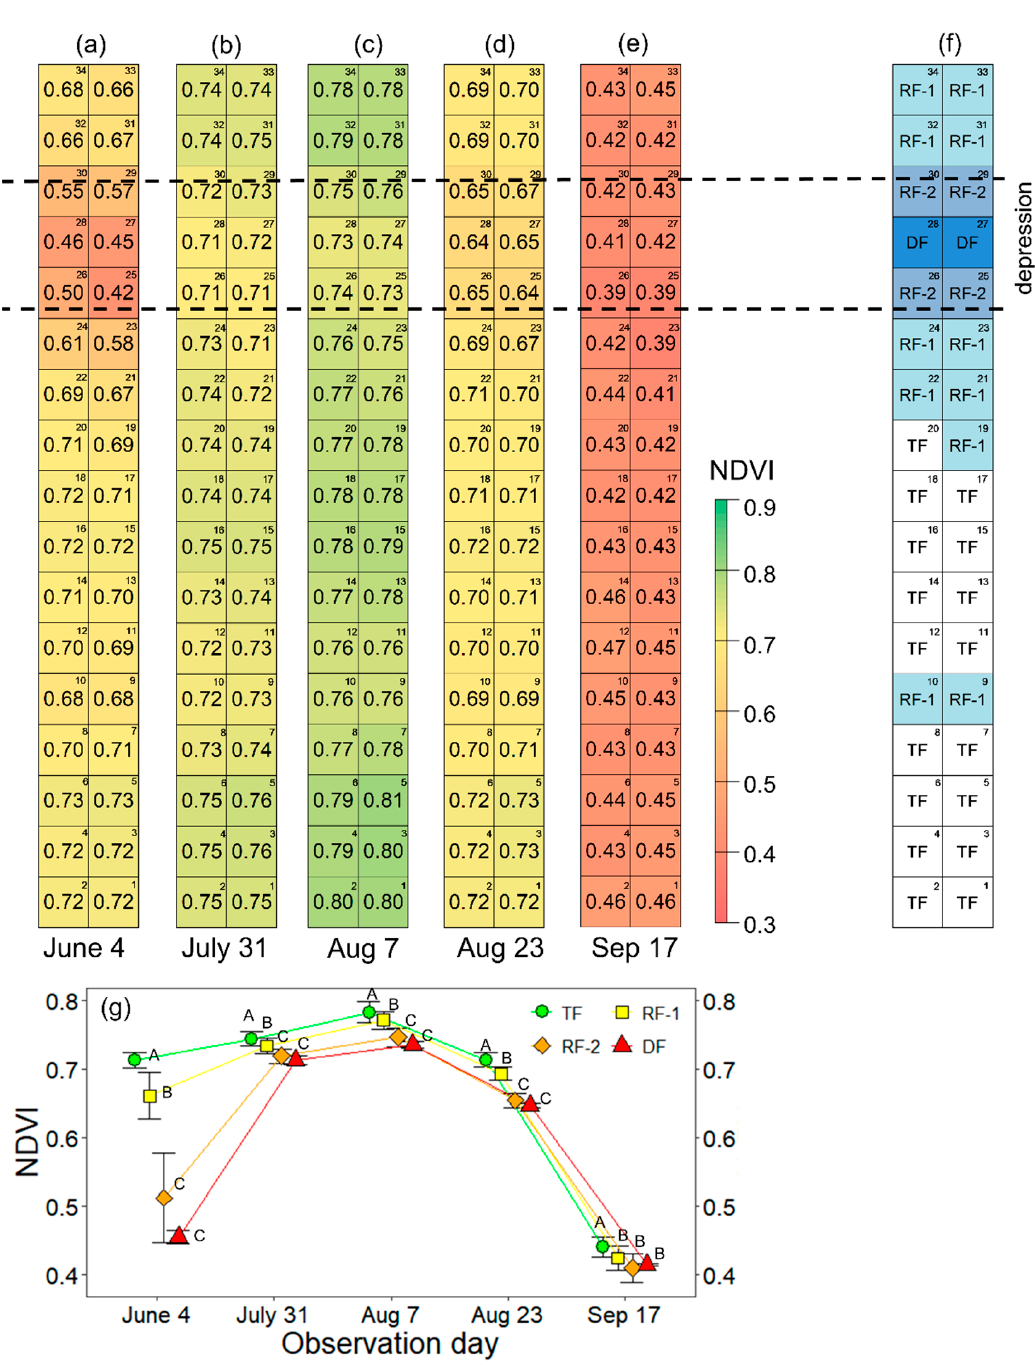
Figure 3. Spatial variations in the NDVI along the transect calculated based on the Landsat 8 images captured in the summer of 2018: ( a ) on 4 June; ( b ) on 31 July; ( c ) on 7 August; ( d ) on 23 August; ( e ) and on 17 September. Variations are presented as the heat maps with the color scale bar. The central number shows an average value of the NDVI within the plot. Serial numbers of the plots are shown at the top right corners. ( f ) Scheme of the distribution of the four larch forest types on damage levels observed along the transect: typical forest (TF), two types of regenerating forest (RF-1 and RF-2), and damaged forest (DF). The transect plot numbers are shown at the top right corners of the plots. The black dash lines display the conditional borders of the depression in the transect (plots from No. 25 to 30). ( g ) Seasonal variations in the NDVI of the forest types. Different upper-case letters (A, B, C) mean the statistical significance in the comparison among forest types on an observation